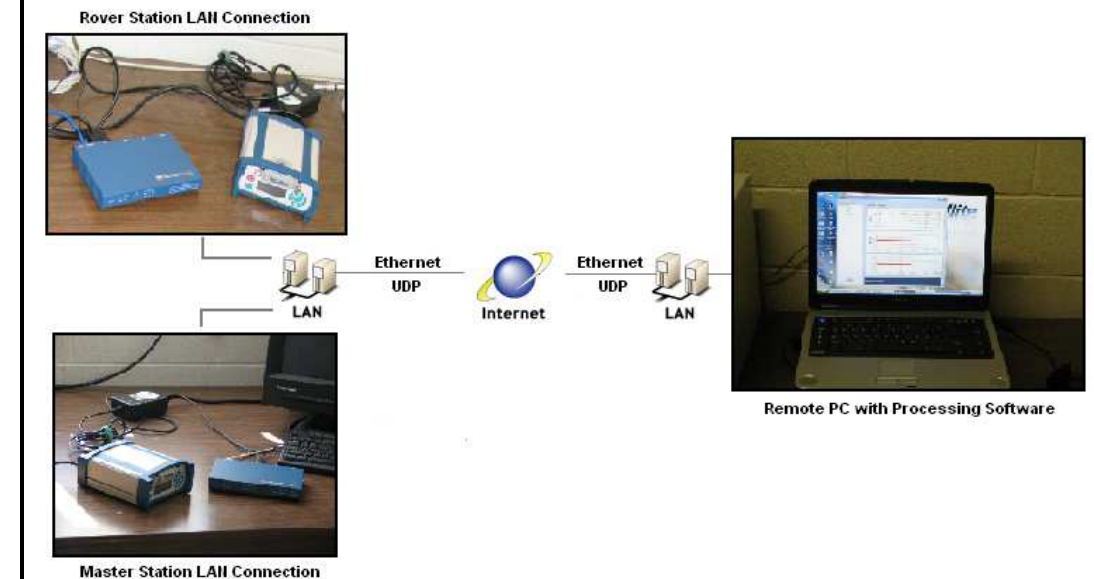
Figure 13. Network Infrastructure and System Configuration for Data Transfer and Remote